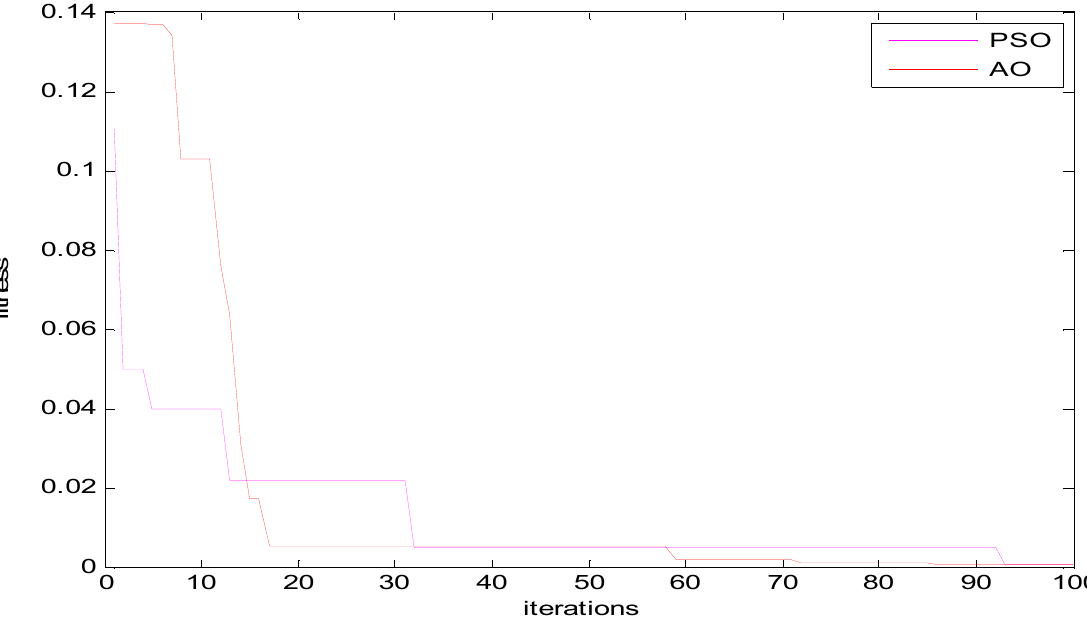
Figure 6. Convergence curves of the compared algorithms for Zafarana site.